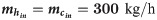
Time evolution of mass production at mhin=mcin=300kg/h.